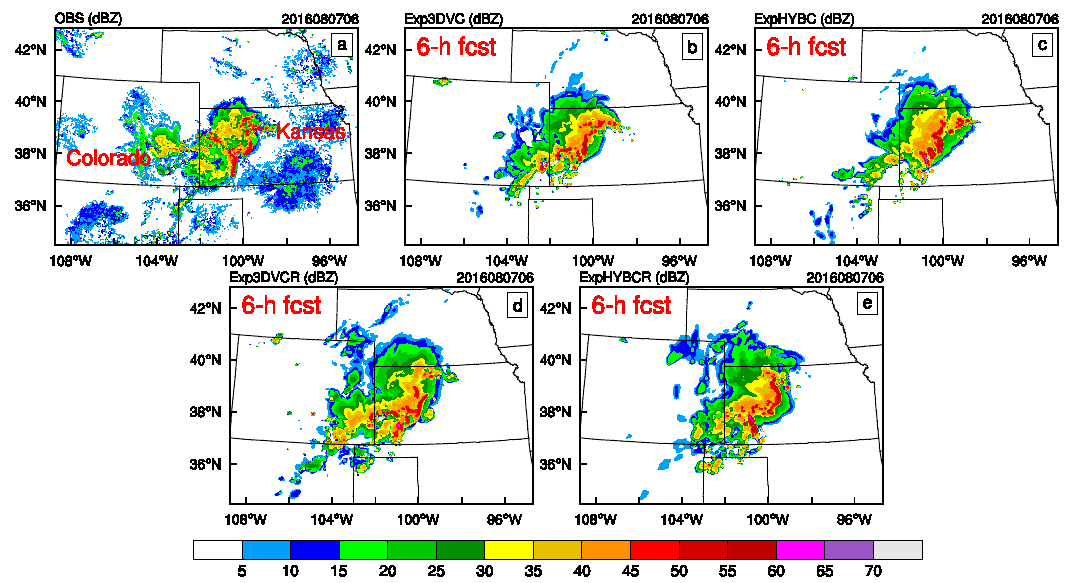
Figure 12. Composite reflectivity (unit: dB Z ) of: observation ( a ); Exp3DVC ( b ); ExpHYBC ( c ); Exp3DVCR ( d ); and ExpHYBCR ( e ) of the convective system at 06:00 UTC on 7 August 2016 (initialized at 00:00 UTC on 7 August 2016).